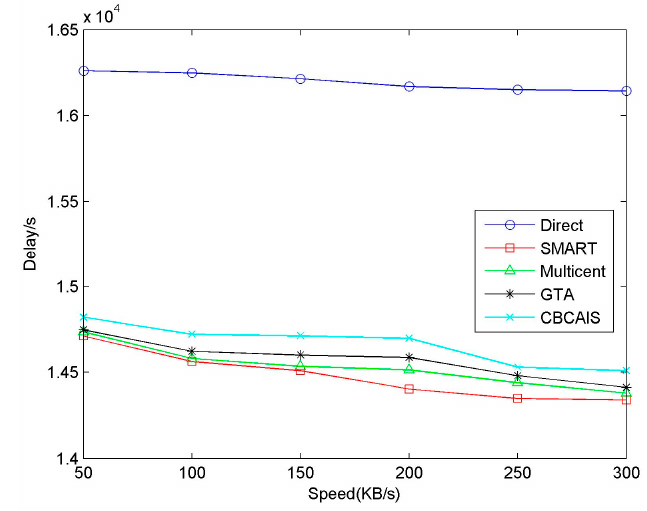
Figure 22. Delay with varying transmission speeds.